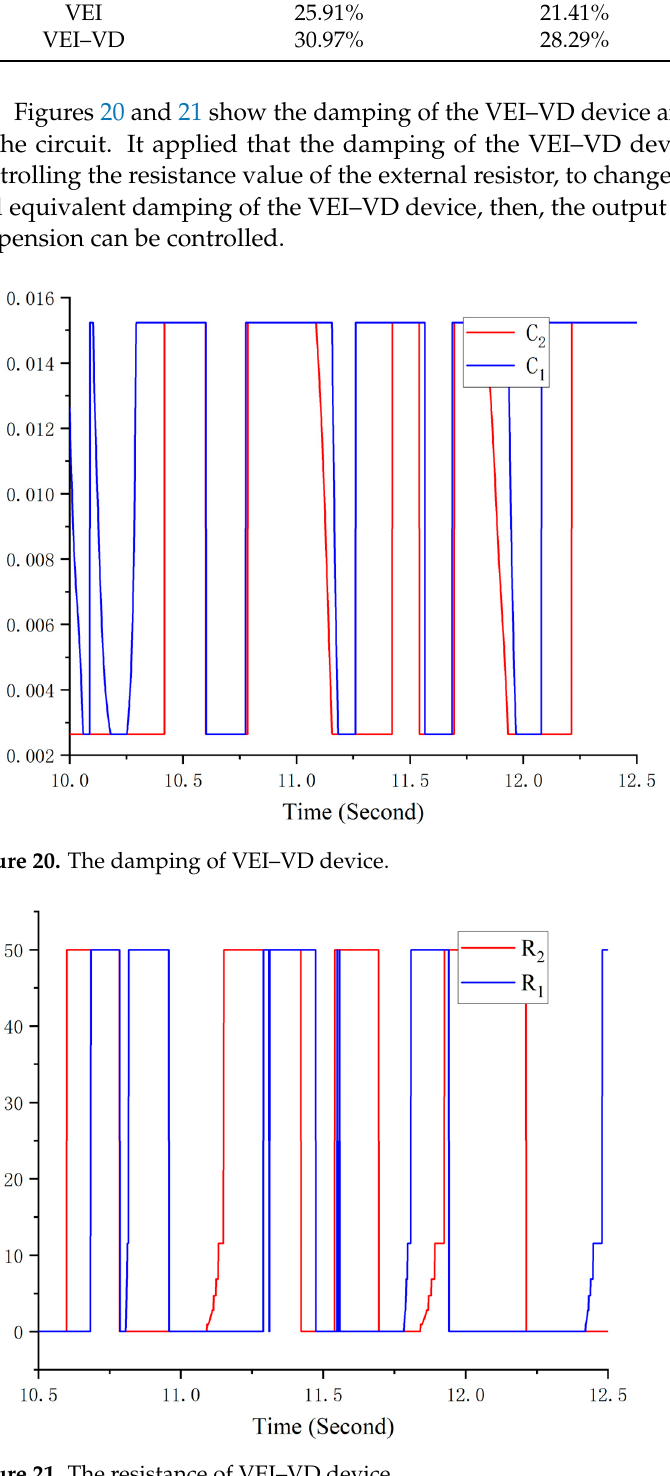
Figure 19. Evaluation parameters of seat acceleration: ( a ) FW-RMS; ( b ) VDV; ( c ) RMS. Table 3. Vibration reduction compared to passive.